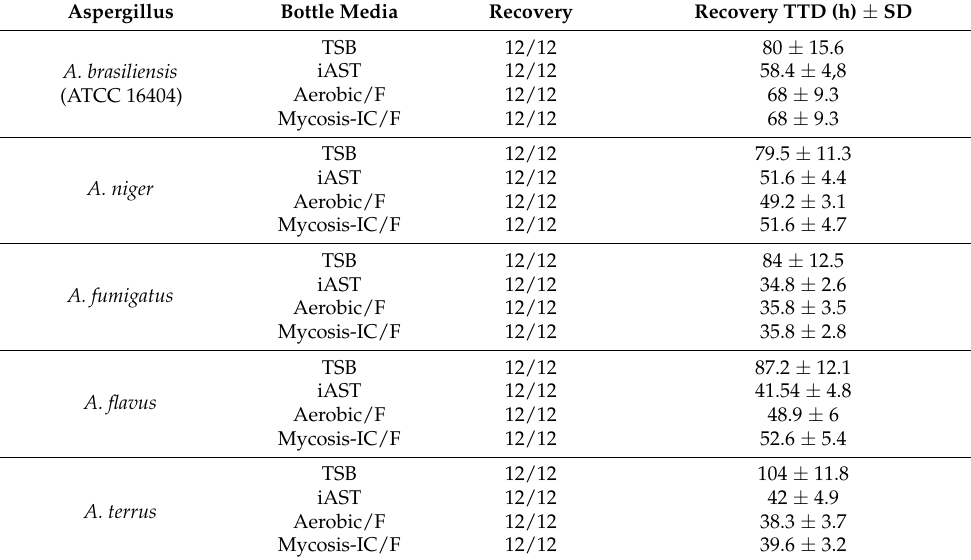
Table 2. Growth Promotion Test. Specificity analysis and